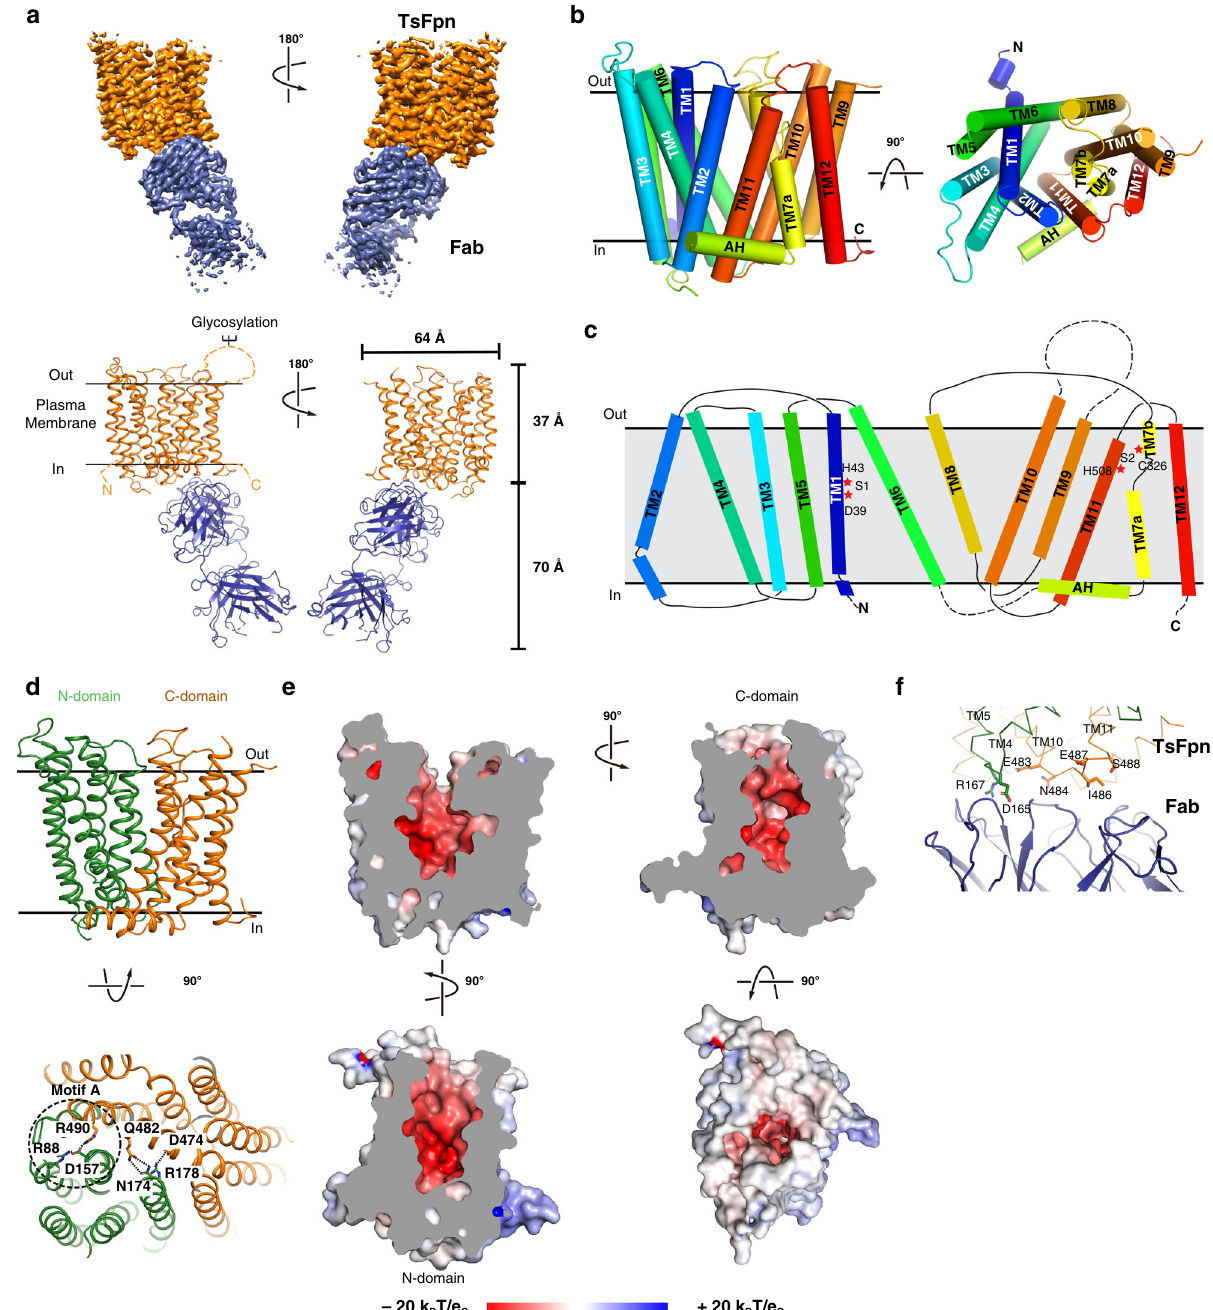
Fig. 2 Structure of TsFpn. a Top panel: cryo-EM map of TsFpn (orange) in complex with Fab (blue) in two views. Bottom panel: TsFpn in complex with Fab shown as ribbon representation in two views. b TsFpn structure shown as cylinder representation in two views. c Topology of TsFpn. Regions that are not resolved in the structure are marked as dotted lines. d Top: The N- and C-domains of TsFpn shown in green and orange, respectively. Bottom: TsFpn viewed from the intracellular side. Interacting residues from the N- and C-domains are marked as sticks. e Electrostatic potential of TsFpn mapped onto the surface representation. The cut-away views show the large cavity formed between the N- and C- domains. Electrostatic potential is calculated by APBS 55 in Pymol. f Interface between TsFpn (green and orange ribbons) and Fab (blue cartoon). Residues from the loop between TM10-11 are shown as orange sticks, and the two charged residues from the N-domain are shown as green